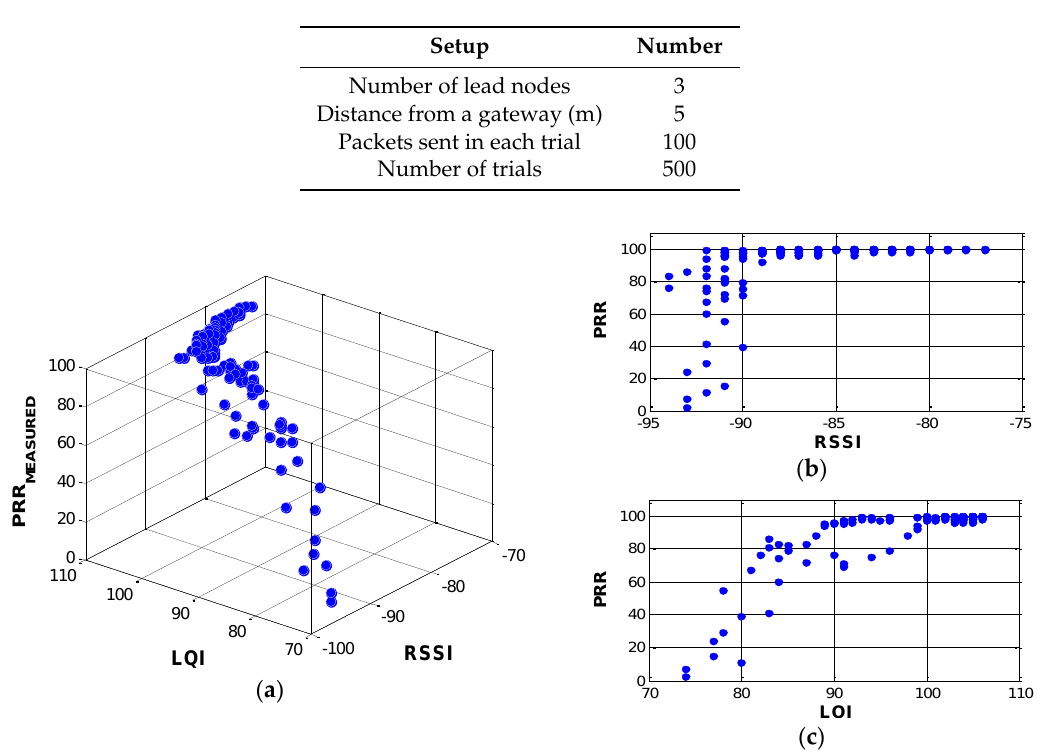
Figure 3. Relationships among PRR, RSSI, and LQI: ( a ) RSSI-LQI-PRR; ( b ) RSSI-PRR; and ( c ) LQI-PRR.